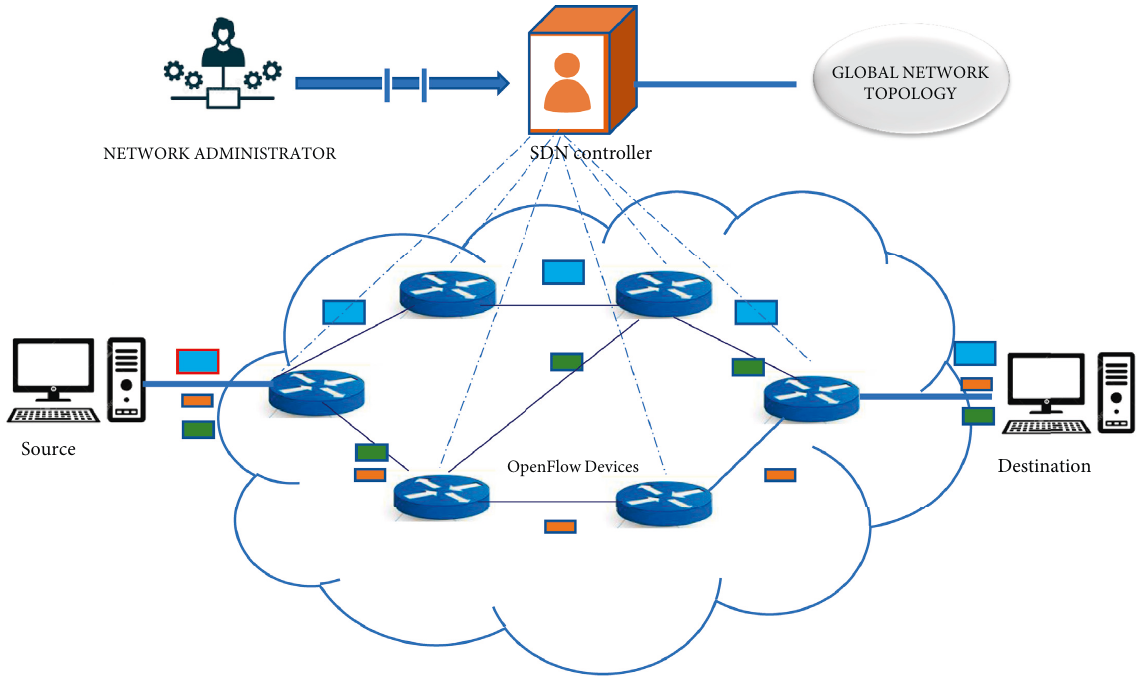
Figure 4: Overview of network programmability Table 4: SDN protocols.